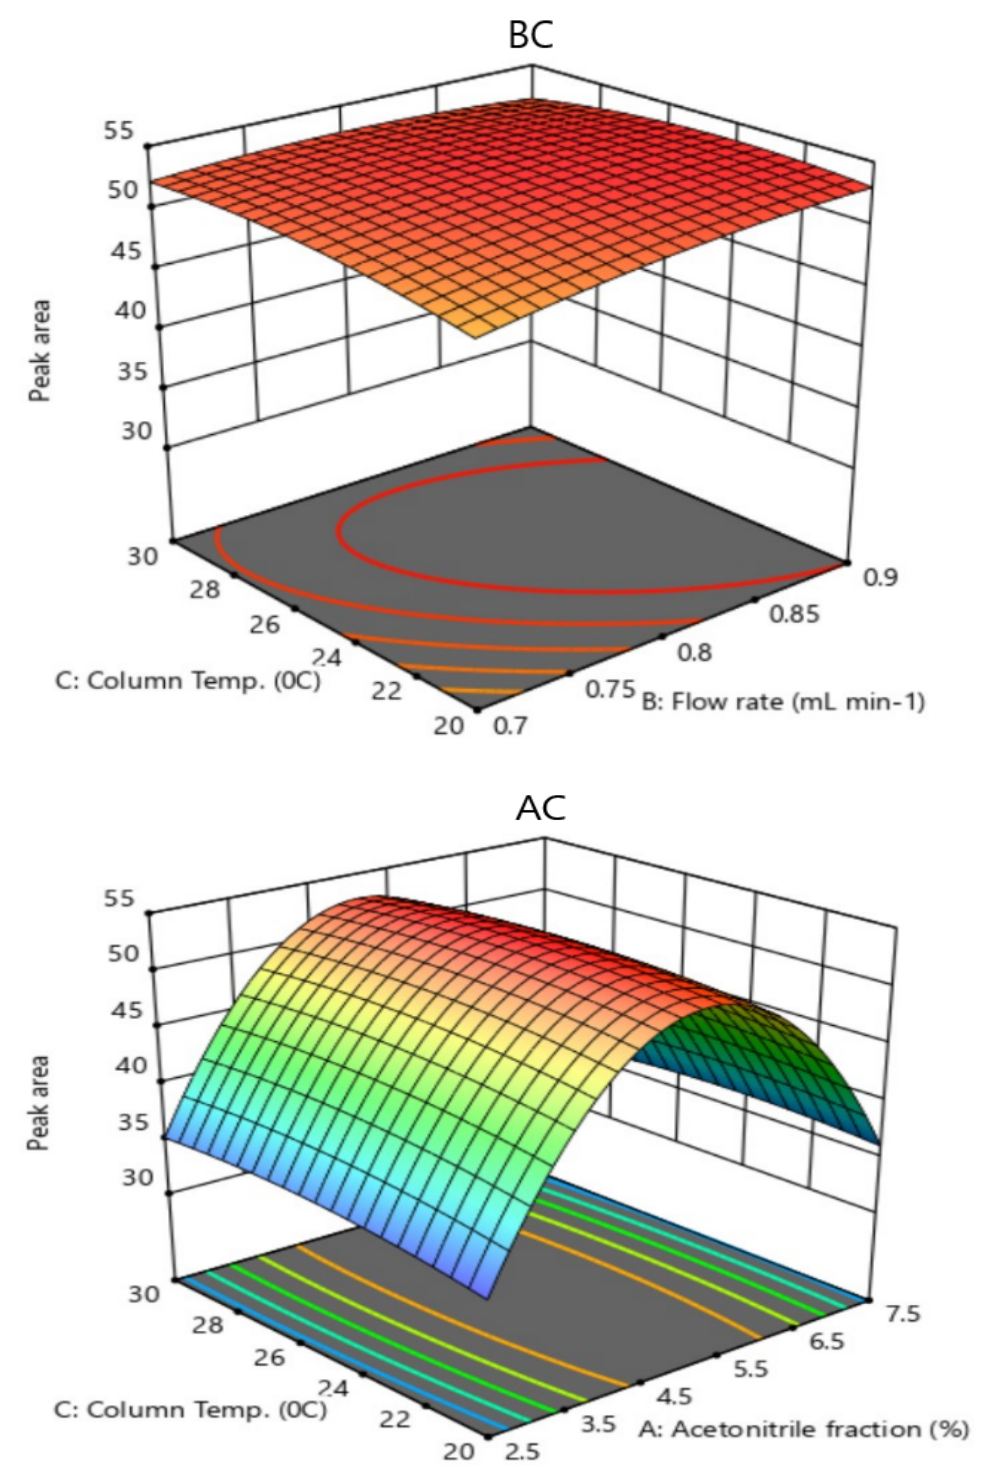
Figure 3. Three-dimensional response surface plots as a function of (BC): flow rate (mL min − 1 ) and column temperature (°C) and (AC): acetonitrile fraction (%) and column temperature (°C) at 50 µg mL − 1 concentration of ascorbic acid on the peak area.